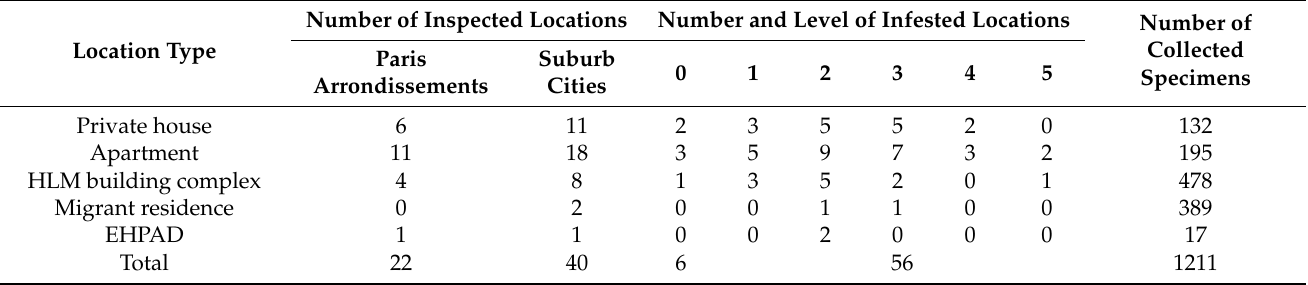
Table 2. Details of bed bug infestations in various locations observed by visual inspection in Paris and suburb cities.